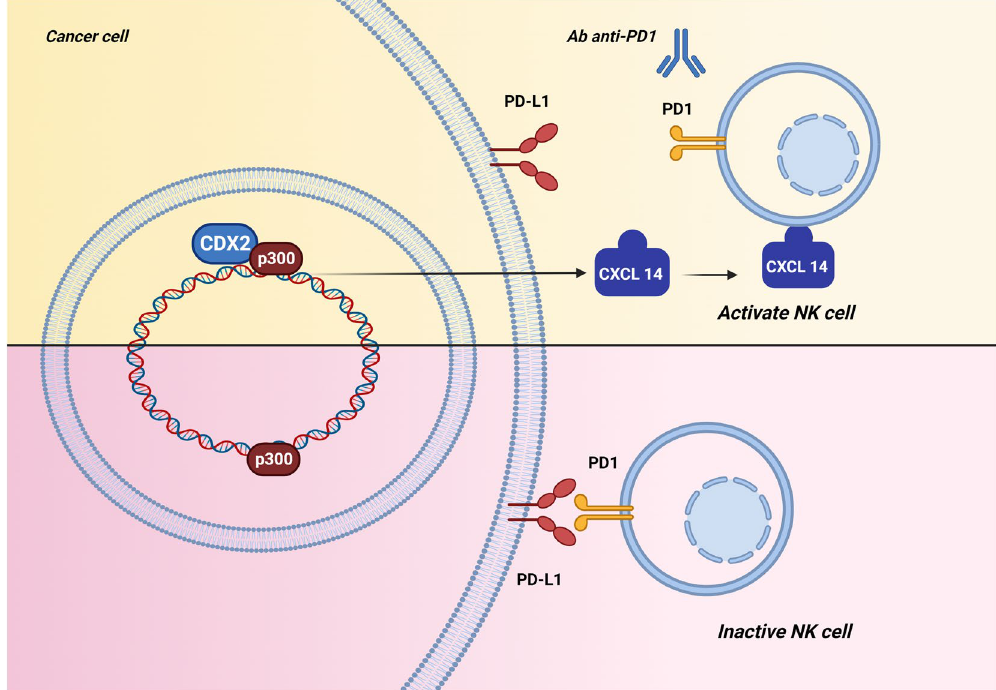
Figure 3. The relationship between CDX-2 expression and immunotherapy response: CDX-2 interacts with histone acetyltransferase p300. The CDX-2/p300 complex activates the enhancer of CXCL14 to promote its expression. Lack of expression of the CDX2/CXCL14 axis reduces the recruitment of immune cells to the microenvironment, inhibiting the therapeutic efficacy of natural killer cell-mediated cancer